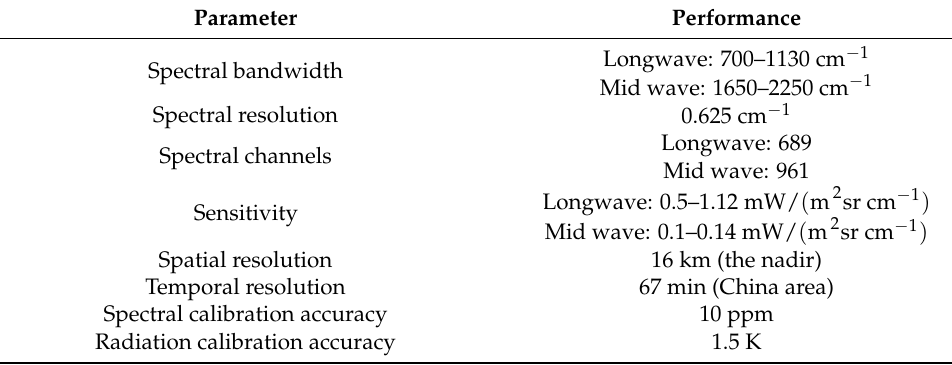
Table 1. Specifications of